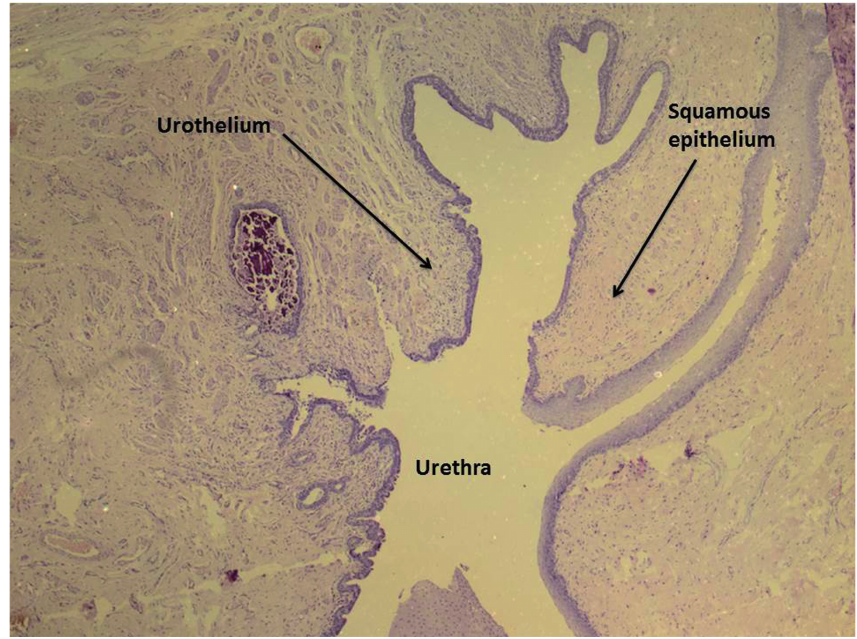
figure 4 - histological aspect of urethral ulceration and fistula formation with marked inflammatory process (group 2 weeks, hE x